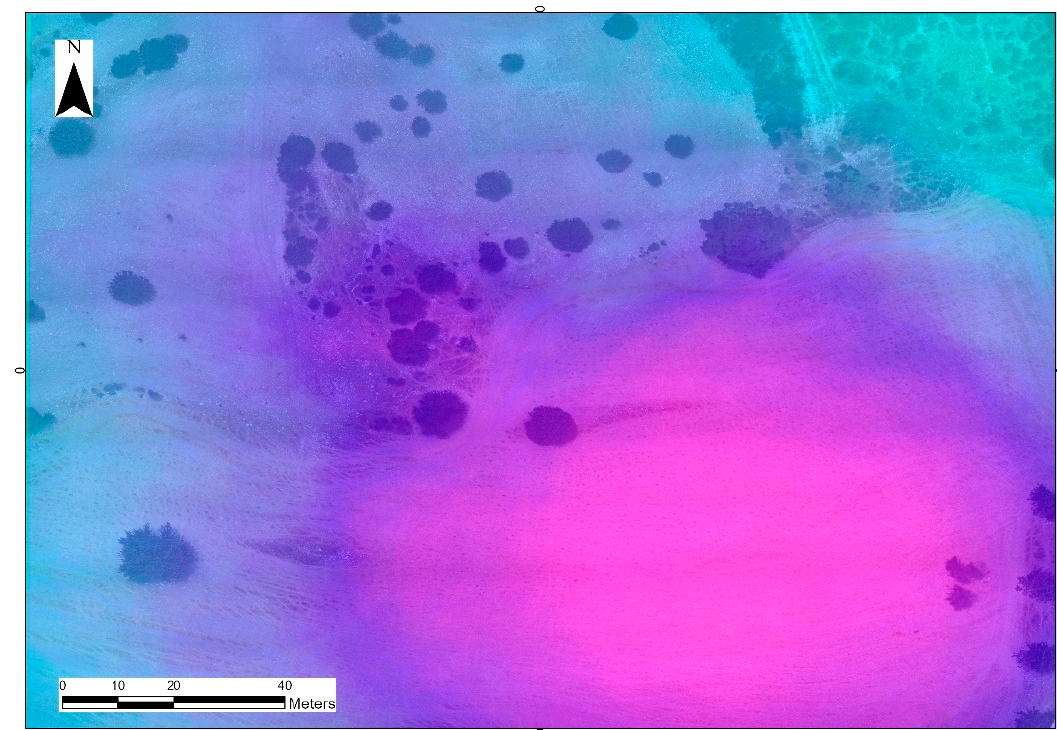
Figure 11. Potsherd distribution using the Single Shot Detector algorithm in Area 6. Areas indicated with purple colour show a higher concentration of potsherds, while those in blue indicate thinner ceramic concentrations.